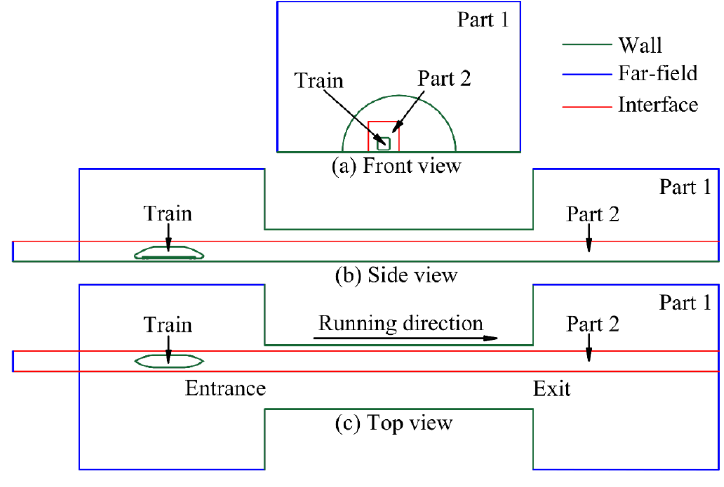
Figure 4. Boundary conditions.